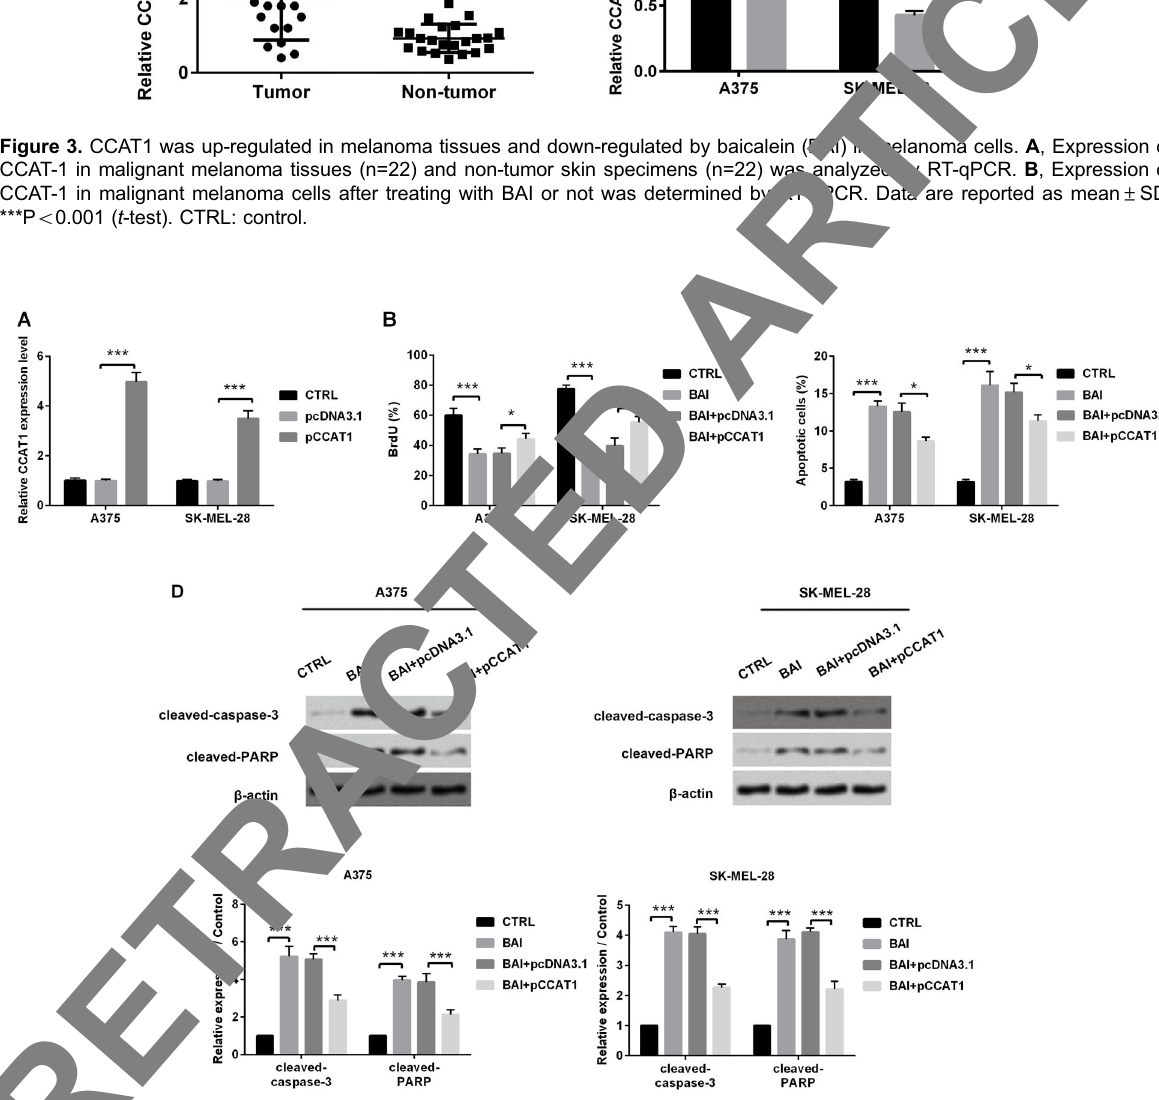
Figure 4. Baicalein (BAI) inhibited the growth of malignant melanoma cells via regulating CCAT1. A , RT-qPCR assay was used to estimate CCAT1 expression in A375 and SK-MEL-28 after transfection with pCCAT1. B and C , BradU assay and fl ow cytometry assays were utilized to evaluate overexpression of CCAT1 and BAI on cell proliferation and apoptosis. D , Western blot assay evaluated the relative expression levels of cleaved-caspase-3 and cleaved-PARP. The relative expression of protein was normalized by b -actin. Data are reported as mean ± SD. *P o 0.05, ***P o 0.001 (ANOVA). CTRL: